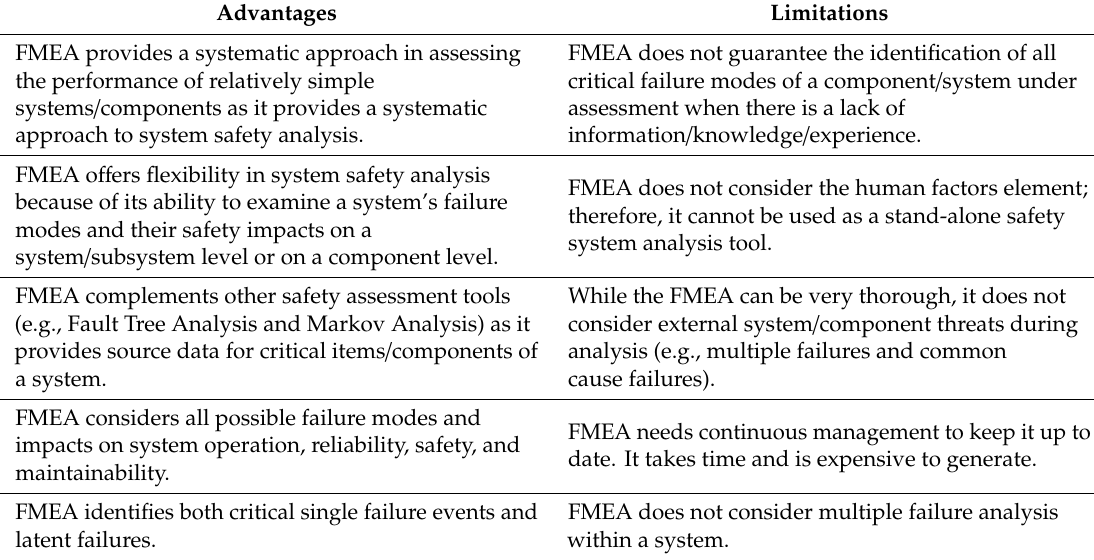
Table 2. Advantages and limitations of Failure Mode E ff ect Analysis (FMEA).